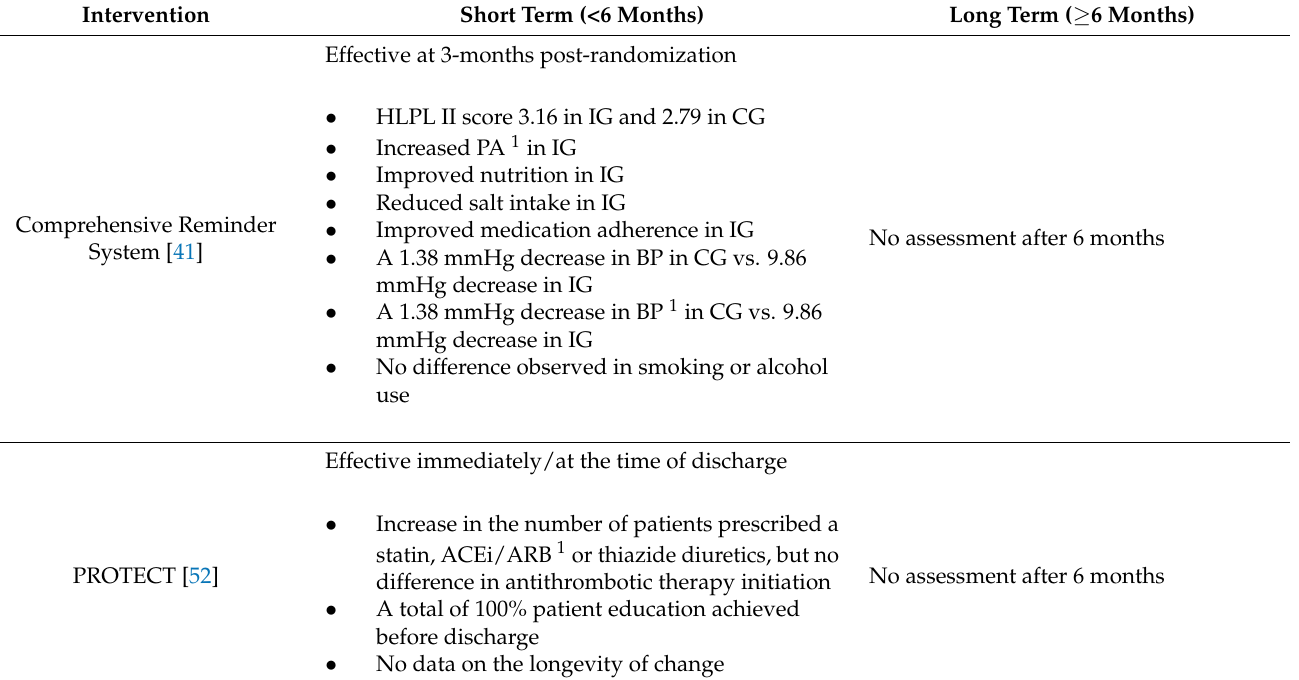
Table 3. Summary of Intervention Effectiveness and Study Results.